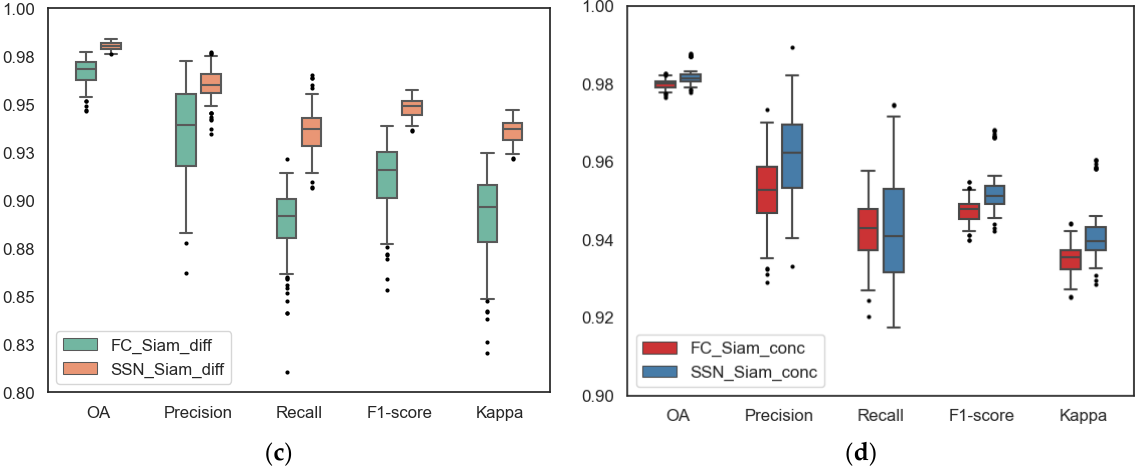
Figure 11. Accuracy indicator distribution of 100 experiments. ( a , b ) refer to the boxplot of FC-Siam- diff vs. SSN-Siam-diff and FC-Siam-conc vs. SSN-Siam-conc for the Ottawa dataset, respectively. Similarly, ( c , d ) correspond to the Sulzberger dataset.